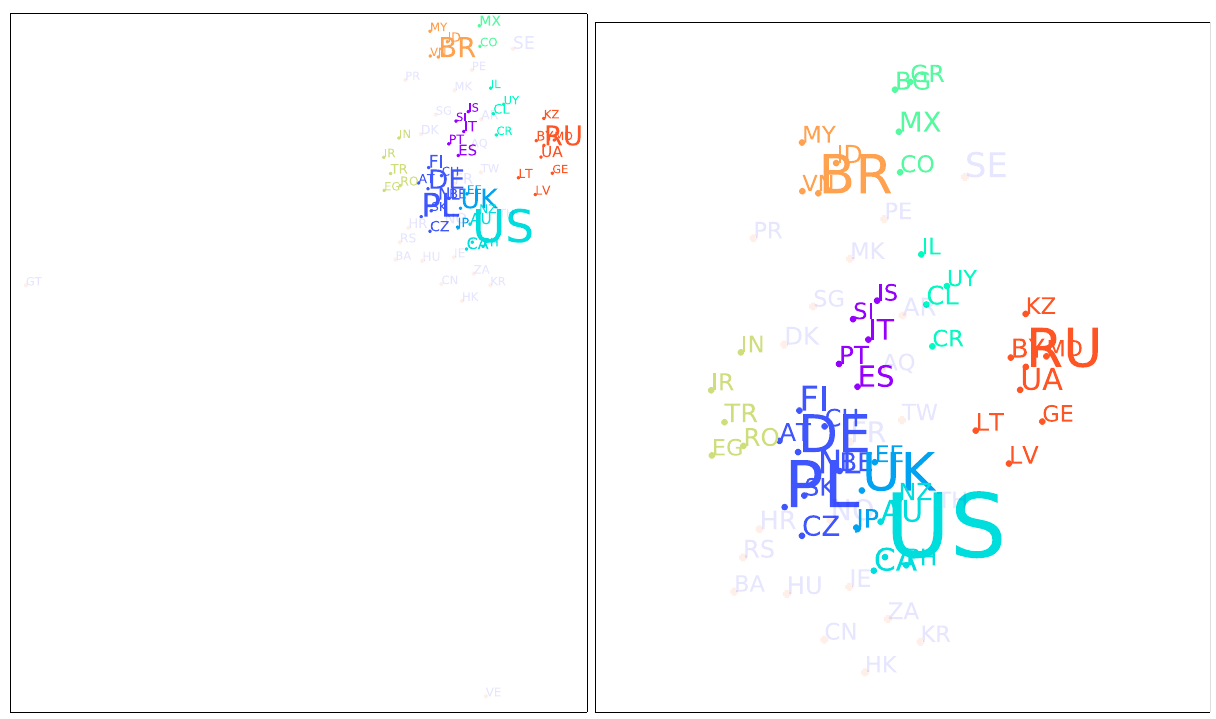
FIGURE8| Resultsoft-SNE(perplexityof5)andOPTICS(minimumclustersizeof3)oncountryfeaturevectors.Theleftpartshowsthefullt-SNEoutputspace,the right part a zoomed version onto the major